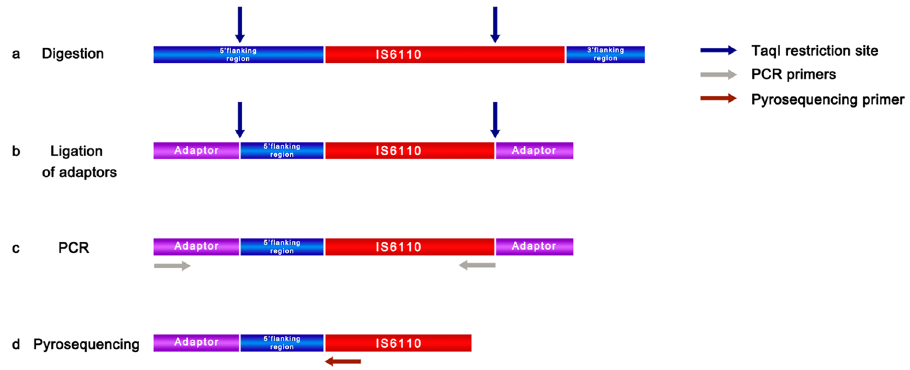
Figure 1. Schematic diagram of the PyroTyping assay. Genomic DNA of M. tuberculosis isolates grown in Löwenstein-Jensen solid medium was extracted by the cetyltrimethylammonium bromide protocol. After, DNA was digested with Tru1I (MseI) and Taq I restriction enzymes (note that the arrows no dot represent the exact restriction sites) ( a ); adaptors were ligated to the Taq I restricted fragments ( b ); the fragments were amplified by PCR using a biotinylated primer complementary to the adaptor and a primer complementary to the IS 6110 ( c ); finally, the amplification product was subjected to pyrosequencing of the 5 ′ IS 6110 -flanking regions by using a primer complementary to the 5 ′ end of the IS 6110 ( d ).